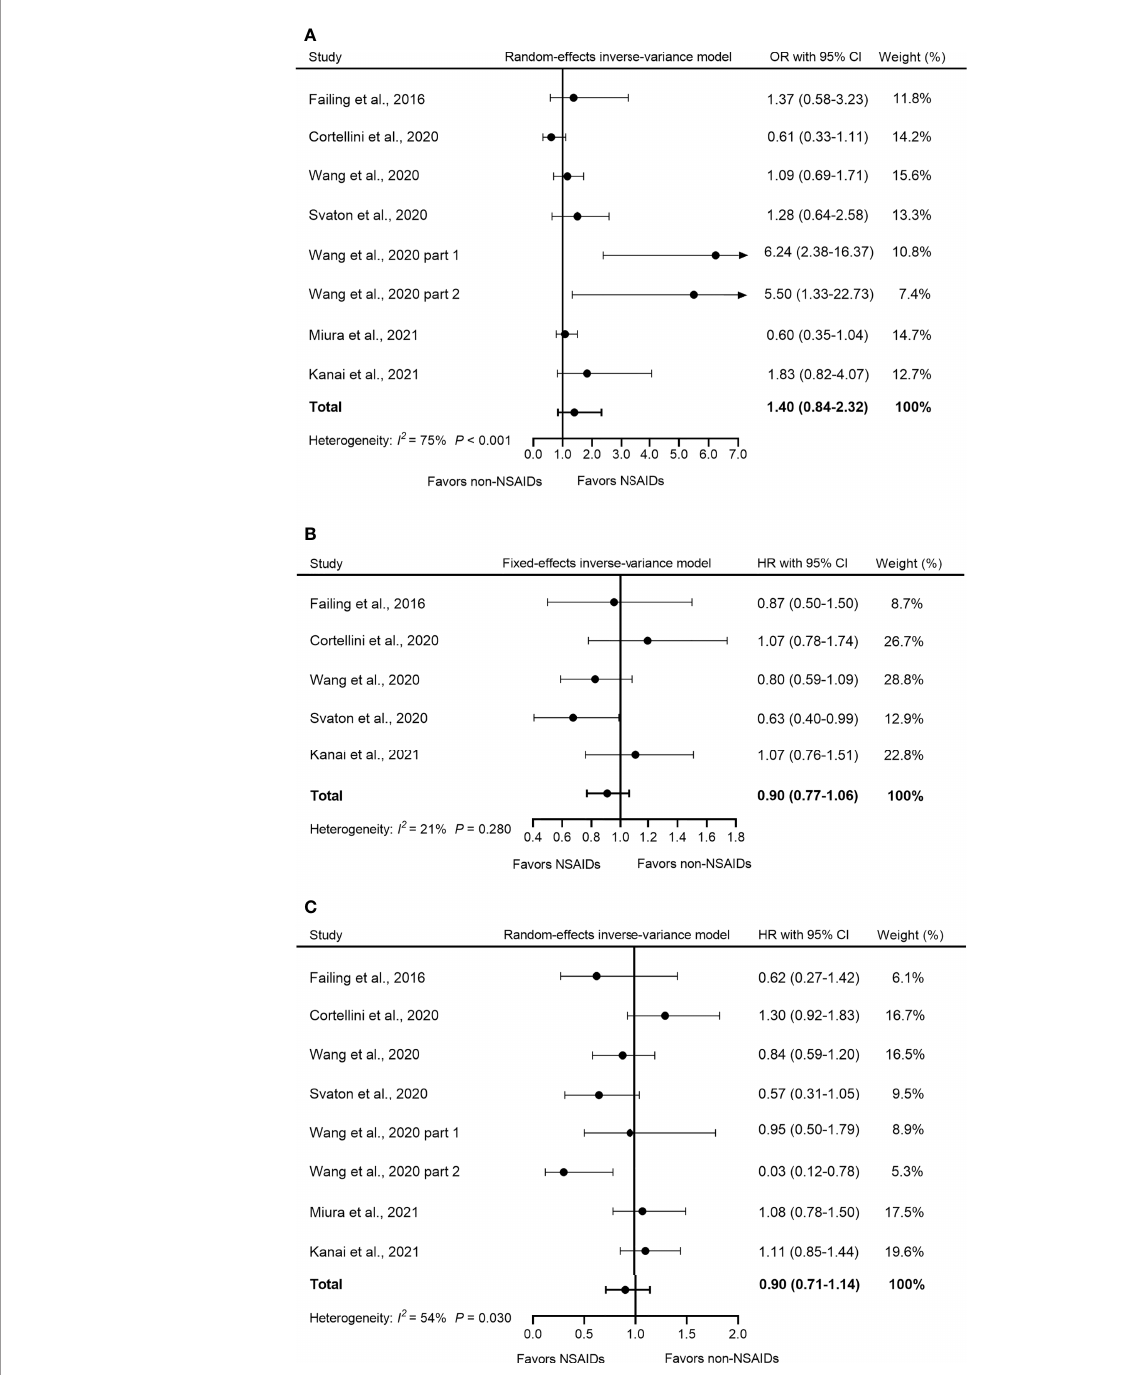
FIGURE 3 | Forest plot of the correlation between concomitant use of NSAIDs and (A) ORR, (B) PFS, and (C) OS in patients receiving ICIs. The study of Wang et al. (2020) included two parts: melanoma and NSCLC with reported OR and OS respectively, so we named them “ Wang et al., 2020 part 1 ” and “ Wang et al., 2020 part 2 ” . The pooled OR of ORR was 1.40 (95% CI = 0.84 – 2.32, p = 0.190) and the random-effects model was adopted. The pooled HR of PFS was 0.90 (95% CI = 0.77 – 1.06, p = 0.186) and the fi xed-effects model was adopted. The combined HR of OS was 0.90 (95% CI = 0.71 – 1.14, p = 0.384) and the random- effects model was adopted. By de fi nition, OR > 1 or HR < 1 implied a better prognosis for NSAID users. NSAIDs, non-steroidal anti-in fl ammatory drugs; ORR, objective response rate; PFS, progression-free survival; OS, overall survival; OR, odds ratio; HR, hazard ratio; CI, con fi dence interval; ICIs, immune checkpoints